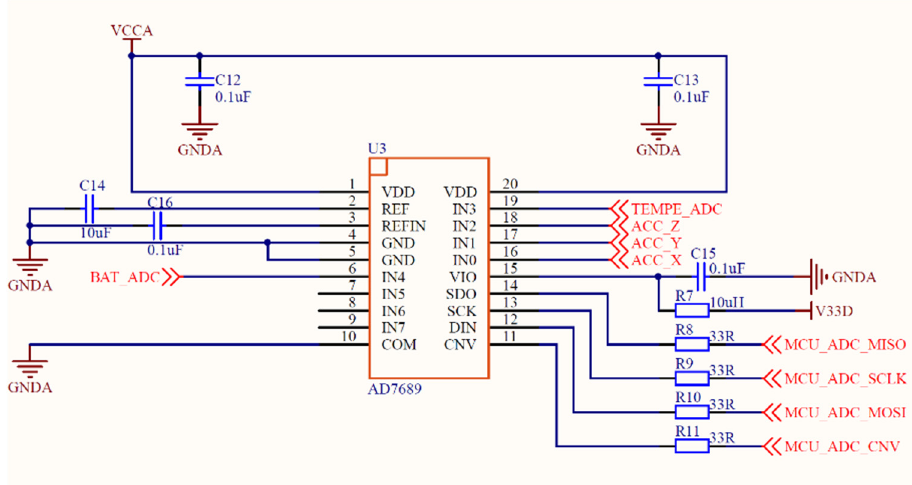
Figure 3. The circuit diagram of AD7689.